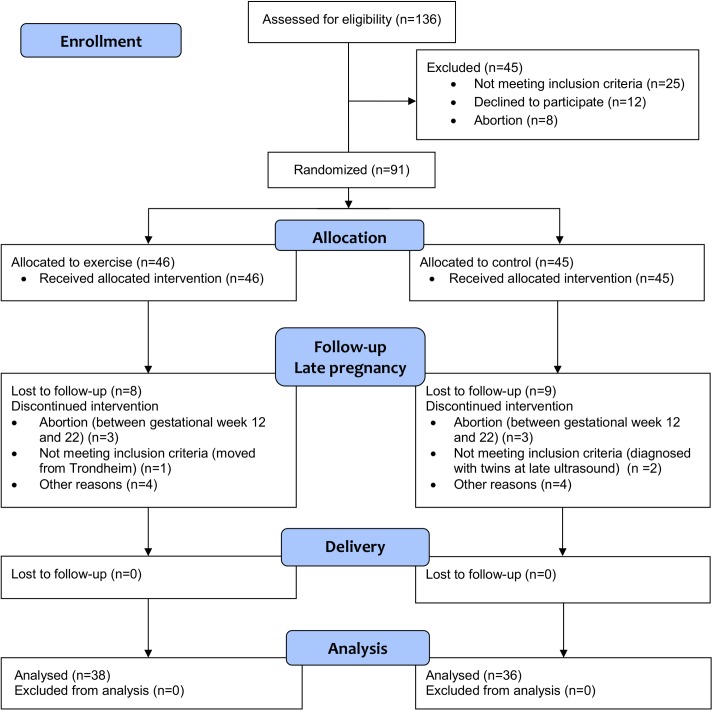
Flow chart of the ETIP trial (CONSORT flow diagram).